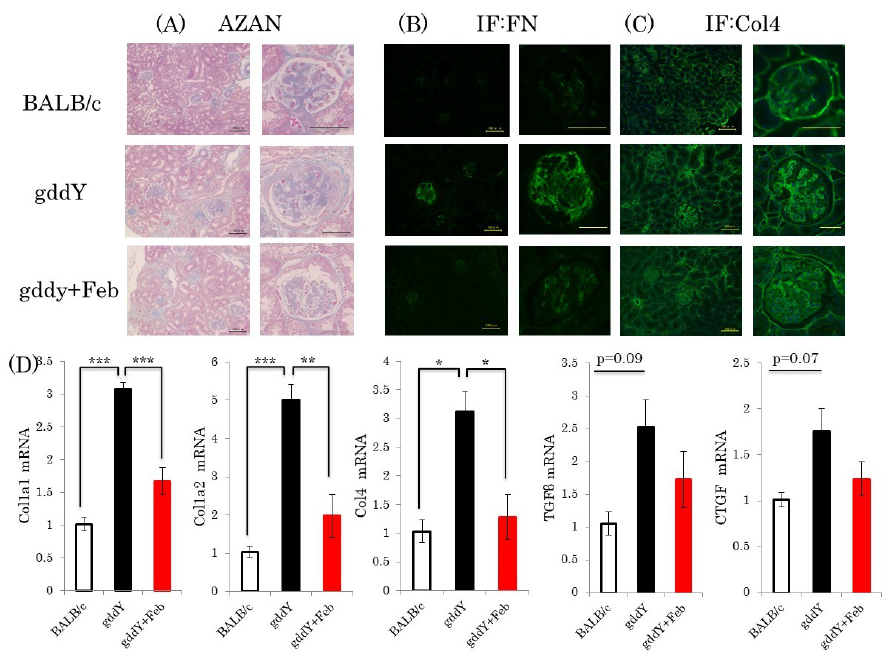
Figure 4. Febuxostat ameliorates kidney fibrosis ( A ) AZAN staining of kidney fractions, scale bar = 100 µ m (left panel), 50 µ m (right panel); ( B , C ) Immunostaining of renal sections with anti-FN or Col4 antibody. Representative images are shown, scale bar = 100 µ m (left panel), 50 µ m (right panel); ( D ) Relative mRNA levels of fibrotic markers in the kidneys were measured. (BALB/c control mice: n = 8, untreated gddY mice: n = 4, febuxostat treated gddY mice: n = 8) *: p < 0.05, **: p < 0.01, ***: p < 0.001.